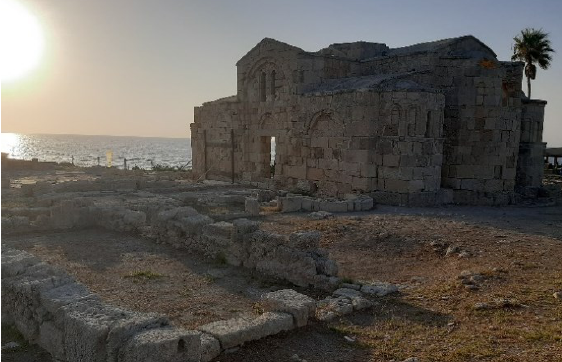
Figure 3. Agios Philon after the restoration,